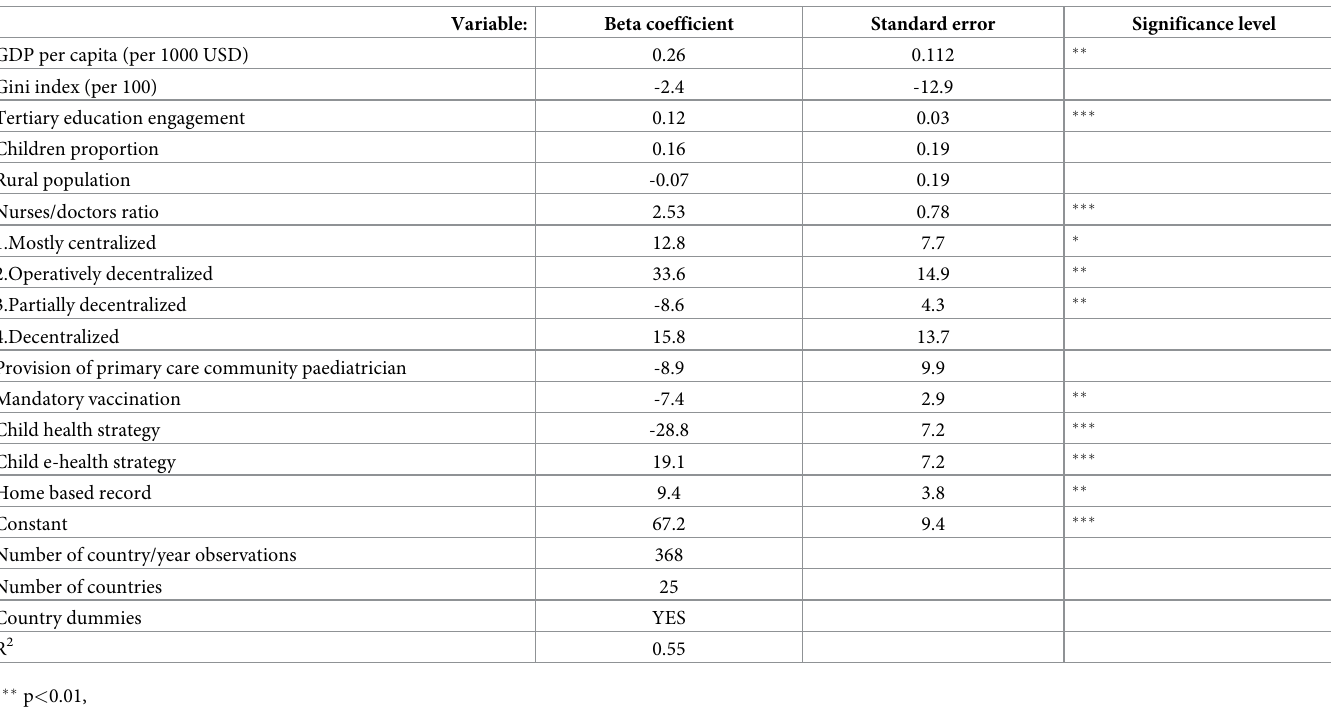
technically unbalanced panel of 25 countries for the timespan 1991–2017 with a total number of 368 country/year observations, as a result of the missing values within countries and years. Table 4 reports the results of the reported regression. For each variable standard errors, rel- evant levels of significance as well as the beta coefficients are reported. Table 4. Results of the regression analysis reporting, for each model and each independent variable, the standard errors and the level of significance in parentheses as well as the relevant beta coefficients. All models were run considering the average vaccination coverage as dependent variable. Variable: Beta